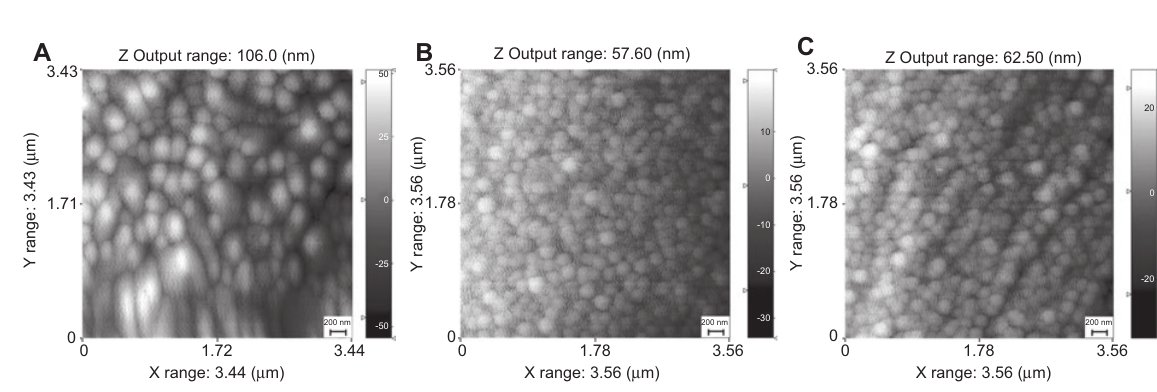
Figure 8 AFM images of fi lms deposited over silicon wafers: (A) aluminum; (B) Al-Si/3 wt. % B